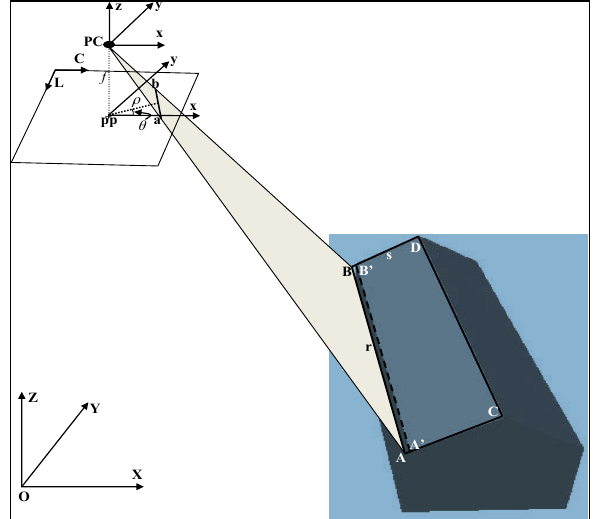
Figure 1. Principle of the proposed photogrammetric method It is possible to demonstrate that the image-space plane defined by the PC and the straight-line segment ab can be expressed in the photogrammetric reference system PCxyz (see Figure 1) as follows,